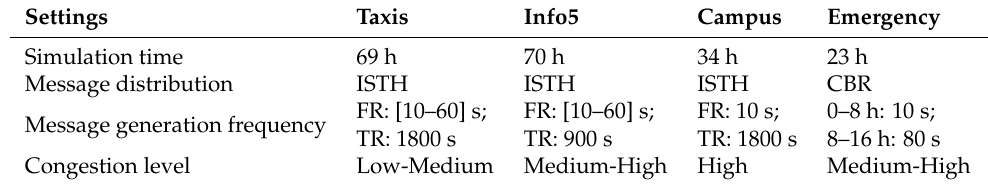
Table 1. Message generation distribution per scenario.